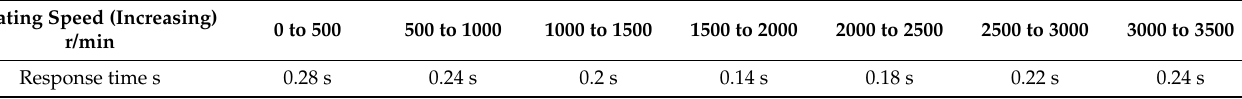
Table 6. Response test of dc motor speed decline of single fertilizer